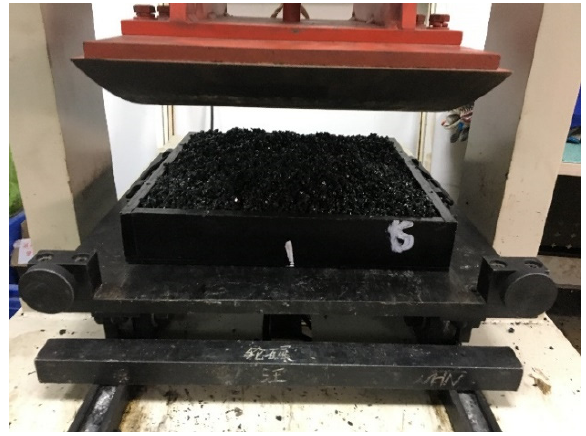
Figure 3. Rolling process of the mixture.